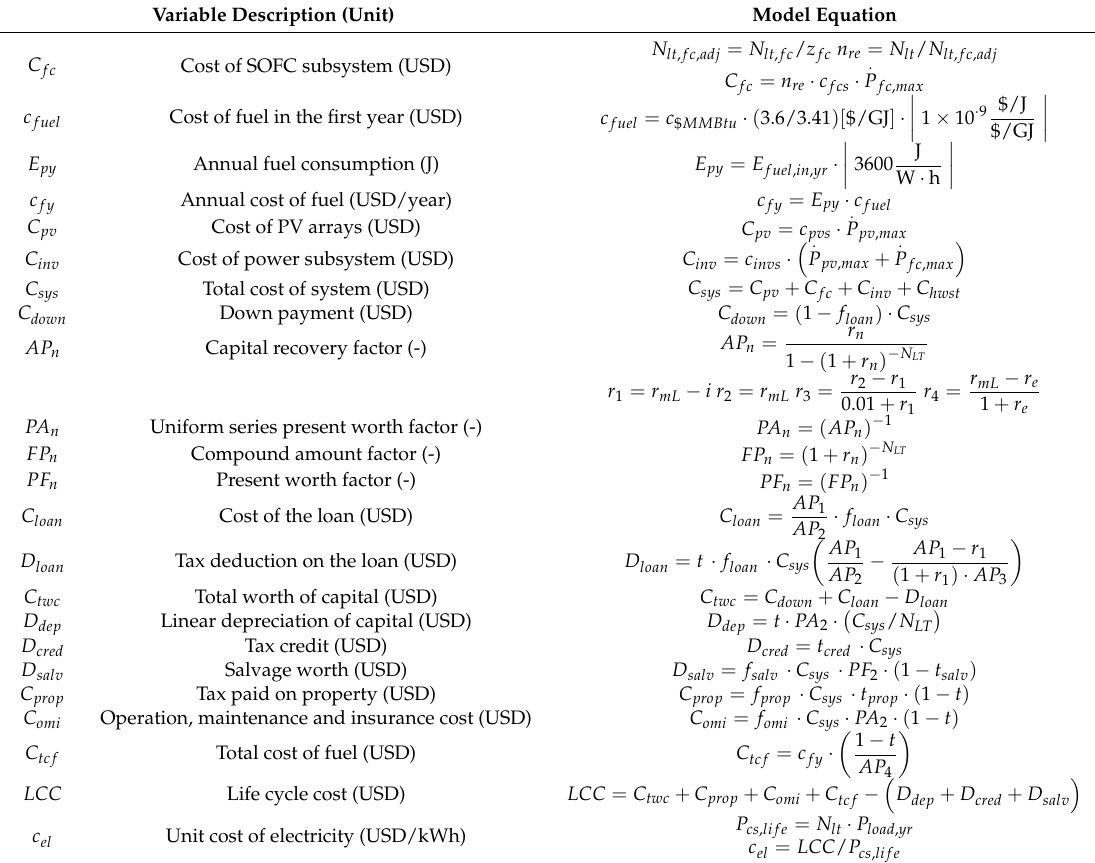
Table 2. Cost modeling equations for the proposed hybrid system.